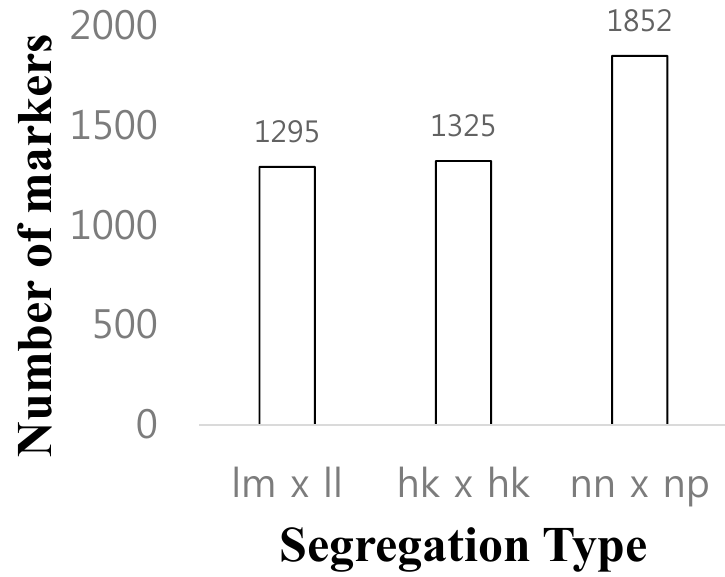
Figure 2. Segregation types of polymorphic SNP markers. The x-axis indicates the three segregation types; the y-axis indicates the number of markers included in each marker type. lm × ll = ‘GX50’ heterozygous ‘GX71’ homozygous. hk × hk = ‘GX50’ heterozygous ‘GX71’ heterozygous. nn × np = ‘GX50’ homozygous ‘GX71’ heterozygous.